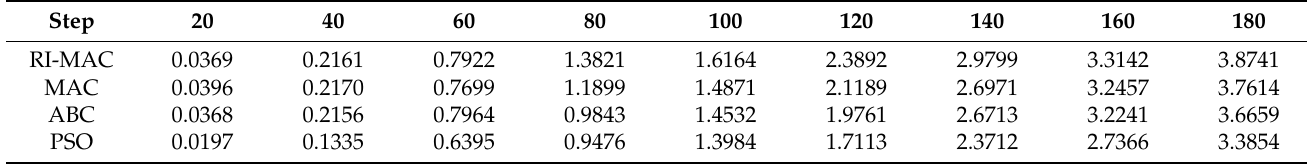
Table 4. Target-discovery benefit of four search algorithms without association rules.